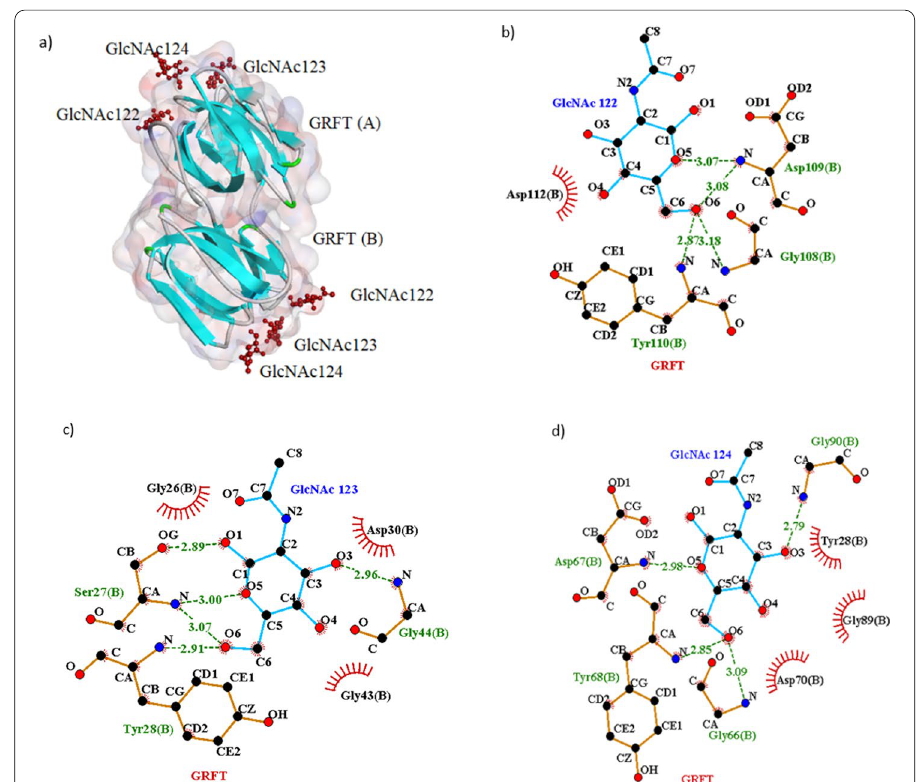
Fig. 1 Interaction between lectin griffithsin (GRFT) (PDB ID: 2NU5) that was homodimer (A and B chain) with N ‑acetylglucosamine (GlcNAc) as ligand. a The interacting domains of the lectin with GlcNAc, depicted by BIOVIA Discovery Studio Visualizer, are shown. In the figure, the lectin is shown schematically in blue, while ligands are shown in scaled ball‑and‑stick style in red. b – d Residues and atoms participating in the interaction between B chain of the lectin and three residues of ligand (GlcNAc 122, 123 and 124), depicted by using the LigPlot + v.2.2 program [15]. The bonds shown by dashed lines in olive‑green color represent hydrogenic bonds, while the bonds shown by radius lines in brick‑red color represent hydrophobic bonds. The numbers on the hydrogen bond show bond distances. Note: Two carbohydrates of N ‑acetylglucosamine and mannose are contained in SARS‑CoV‑2 surface glycan, and the residues are exposed to the innate immune system [16]. So, the crystal structure of complexes of antiviral lectin GRFT with glucose and N ‑acetylglucosamine were solved and refined at high resolution. In both complexes, all six monosaccharide‑binding sites of GRFT were occupied, and the mode of binding was similar to that of mannose [17]. Therefore, as an example of multiple lectins, the interaction pattern of GRFT with GlcNAc is selected to be shown in the